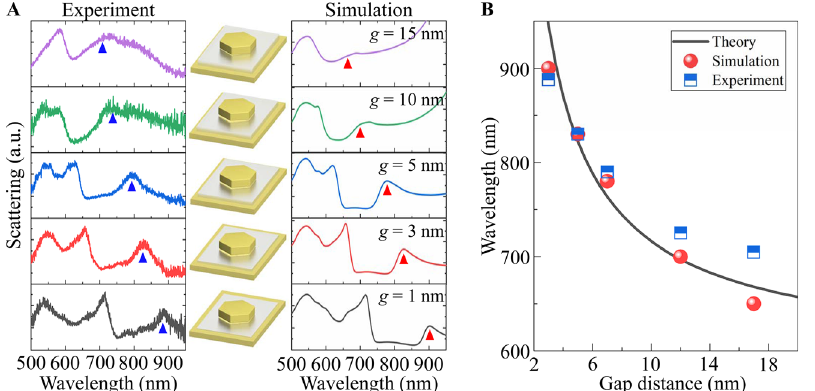
Figure 4: (A) Scattering spectra of hexagonal Au NPoMs ( d = 180 nm) of various gap sizes. The left and right columns are the measured and simulated scattering spectra with triangles indicating the dispersion of RBM. The middle column depicts the NPoMs with different gap sizes. (B) Resonance wavelength of RBM as a function of gap size.